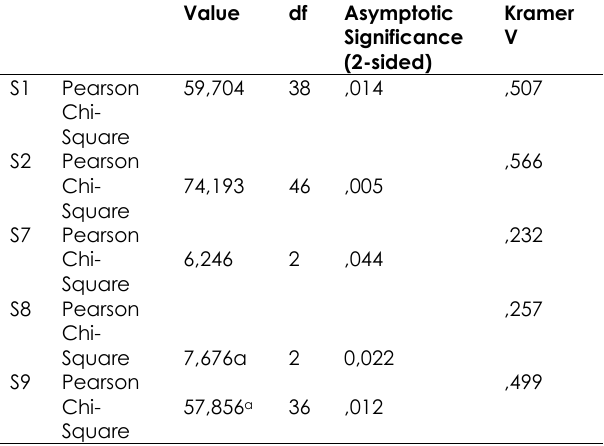
Table 8. The effect of departmental differences on the questions Chi-Square and Cramer V values .